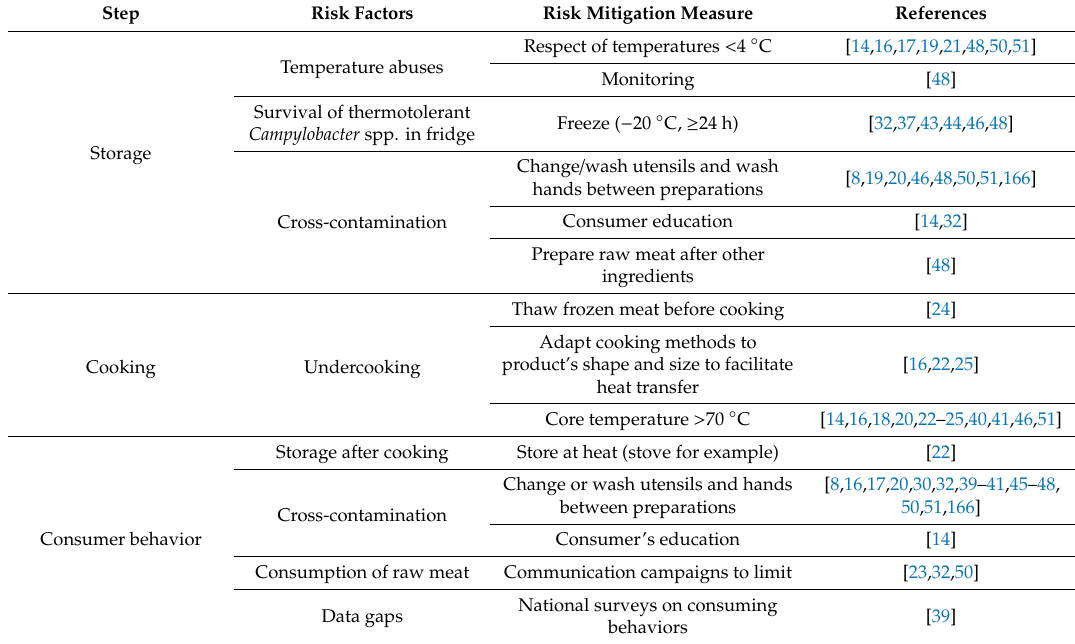
Table 3. Main risk factors and mitigation measures suggested in the consumer